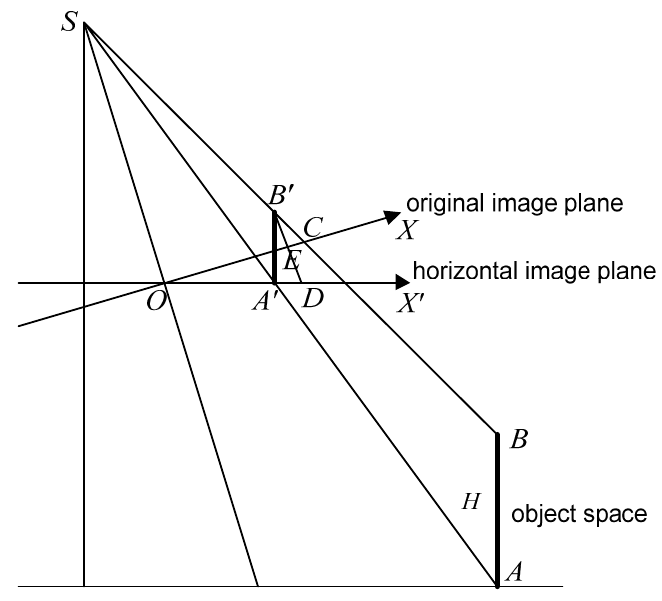
Figure 1. Imaging geometric relationship of a linear array scanner along the scanning direction.